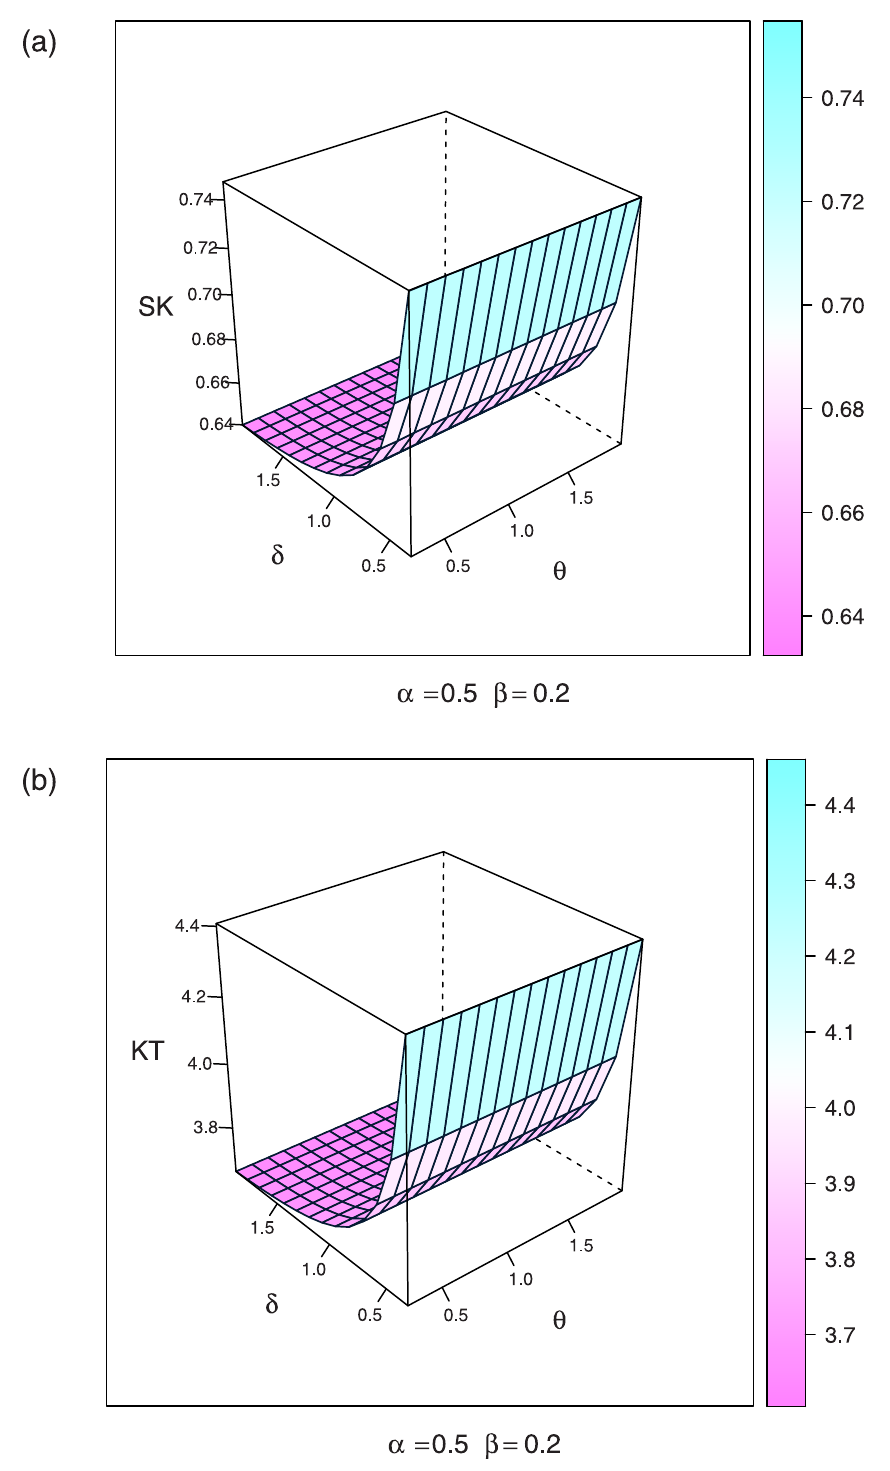
Fig 3. Plots of skewness and kurtosis values the OLINH for some parameter values.